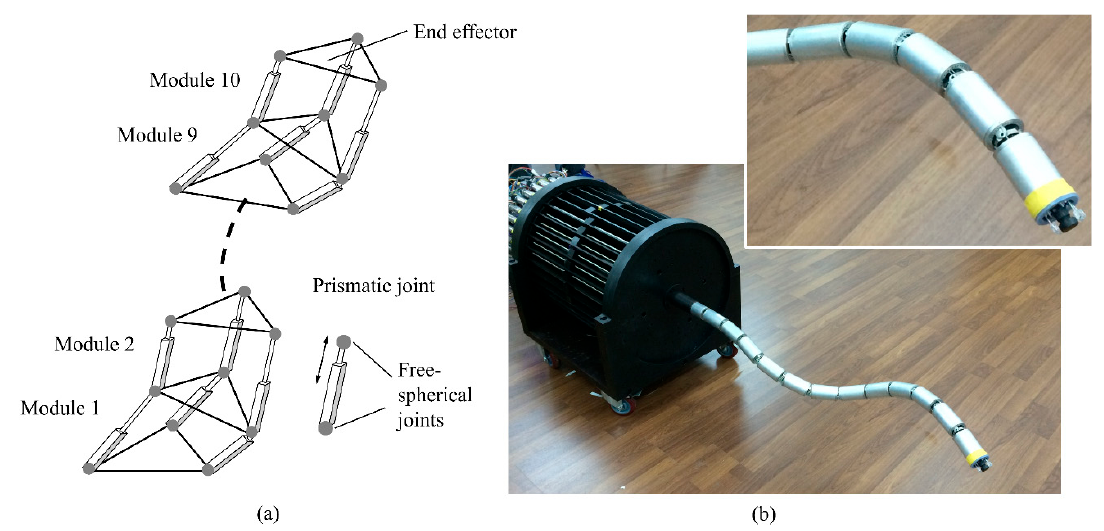
Figure 6. ( a ) A redundant manipulator structure and ( b ) an elephant-trunk/snake manipulator (courtesy of Professor Gu, Shanghai Jiao Tong University [36].